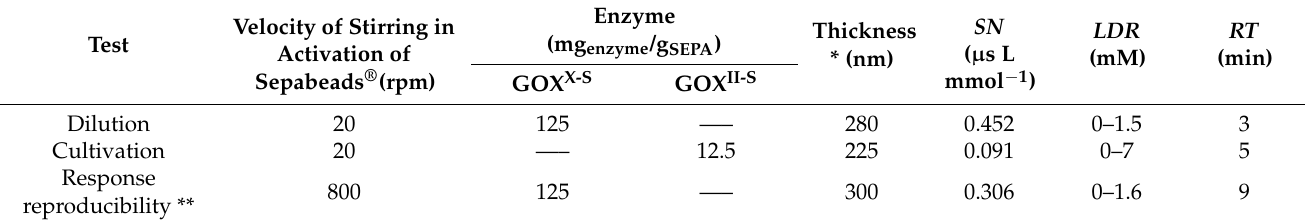
Table 1. Parameters and analytical characteristics of sensitive layers.